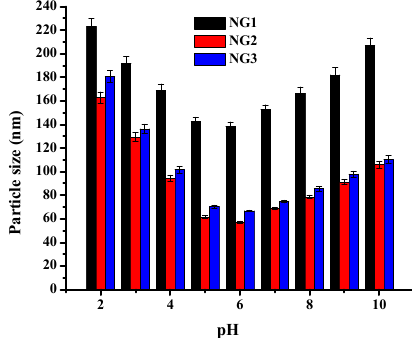
Figure 1. The particle sizes of NG1, NG2 and NG3. The NGs were prepared by ultrasonicating soy protein-dextran mixtures at different pH values for 70 min. Data with different lowercase letters in the same test are significantly ( p < 0.05) different.